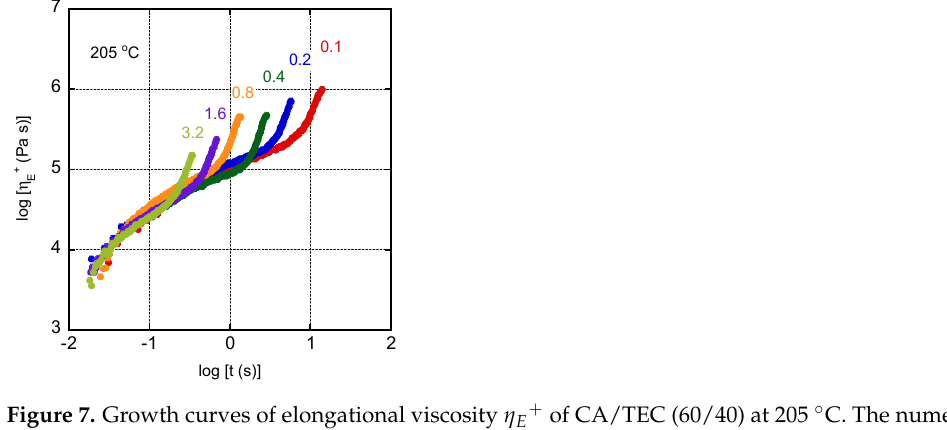
Figure 7. Growth curves of elongational viscosity η E + of CA/TEC (60/40) at 205 ◦ C. The numerals in the figure represent the strain rates (s − 1 ).